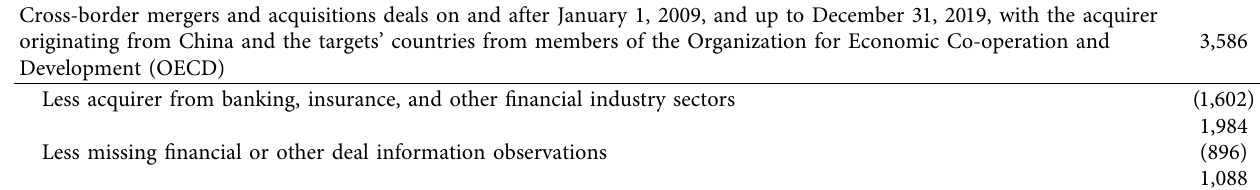
Table 2: Sampling procedure for estimating the probability of success.